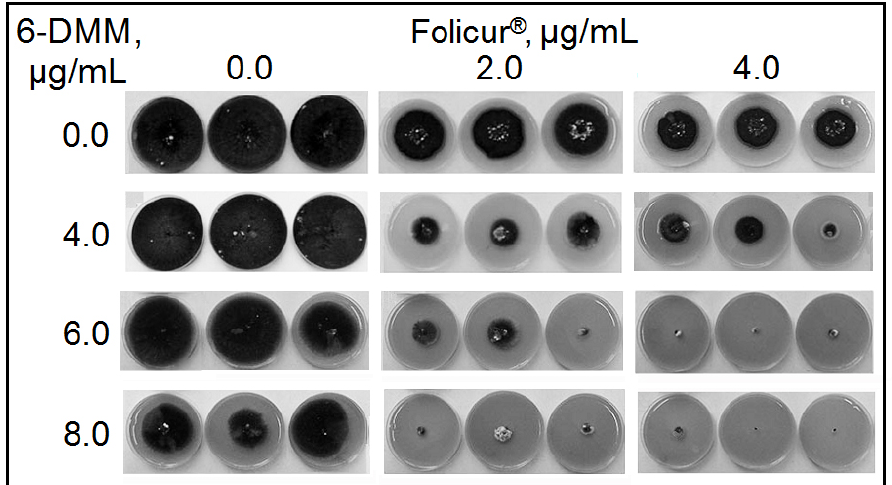
Figure 4. Bipolaris sorokiniana colonies grown for 9 days on potato dextrose agar supplemented with 6-DMM, Folicur ® EC 250, or their combinations. The shown Petri plate cultures represent a typical picture for one of three performed checkerboard assays.